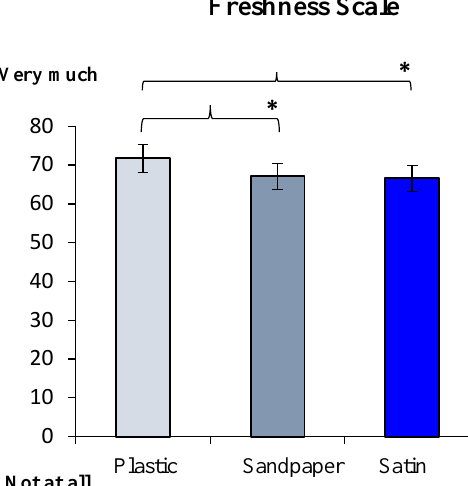
Figure 2. The participants’ mean judgments on the scale measuring freshness perception for both kinds of water as a function of the texture of the glass in which the liquid was served. Error bars represent the standard error of the mean. Asterisks represent Newman–Keuls significant differences at p < 0.05.